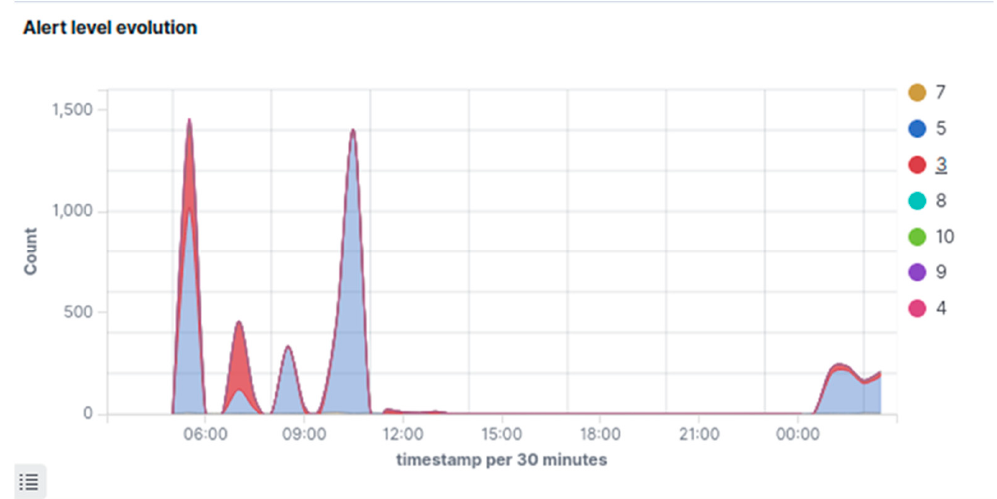
Figure 18 . SWaT Event Monitoring Rules.